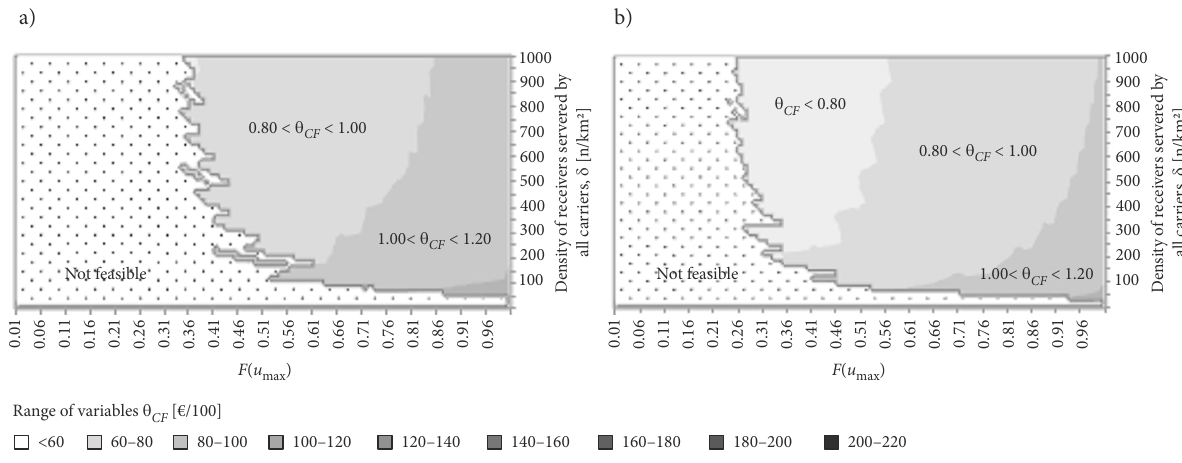
Figure 11. Fare q CF [€]: a – results in Scenario 2.2 ( C CF = 2.4 m 3 ); b – results in Scenario 2.3 ( C CF = 1.2 m 3 )